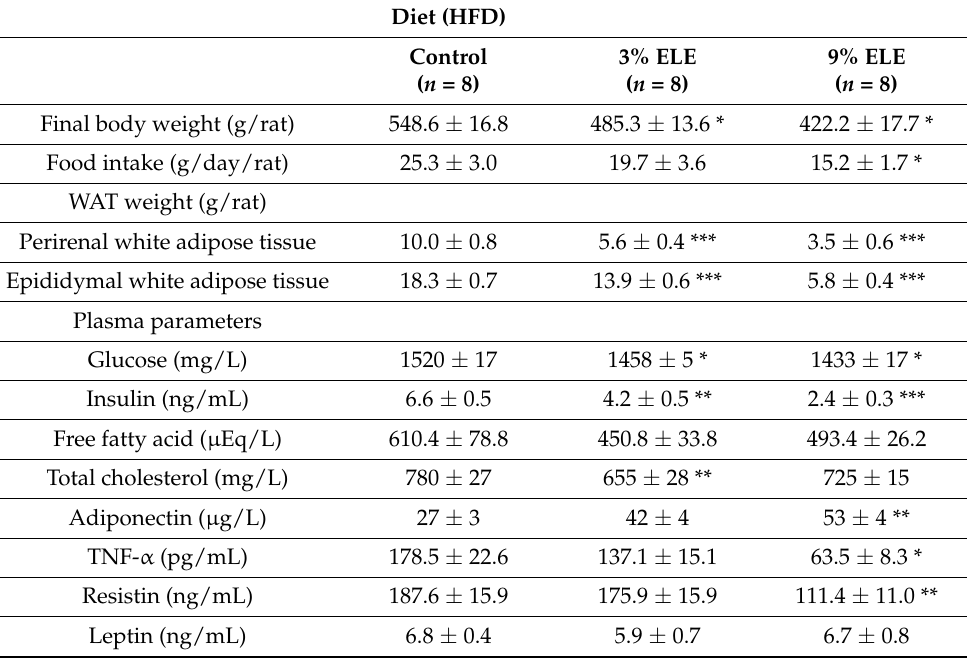
Table 10. Effects of ELE on physical and plasma parameters in HFD-fed rats after three months.